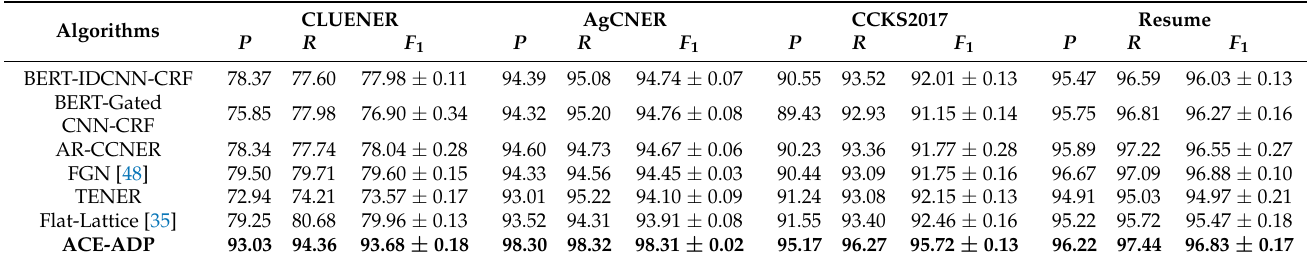
Table 3. Experimental results for all models on four different